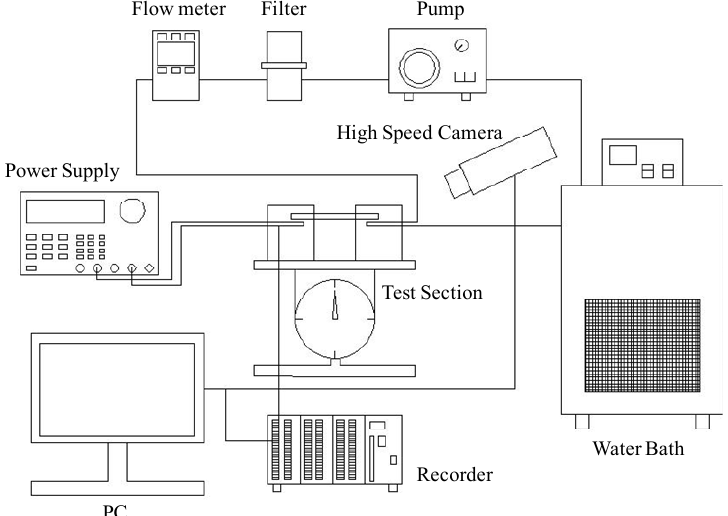
Figure 1. Schematic of the experimental set